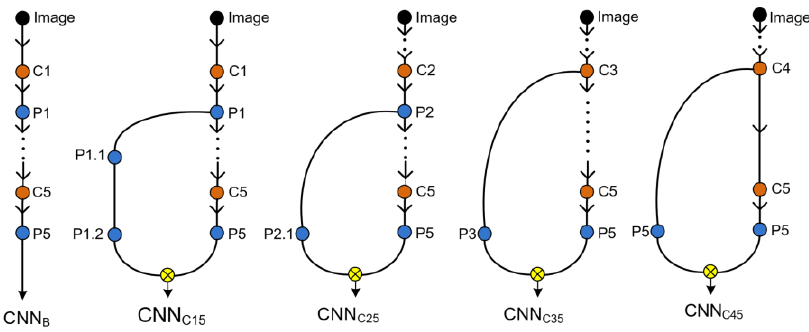
Figure 15. Different layers aggregation structures of proposed CNN model. Figure 15. Di ff erent layers aggregation structures of proposed CNN model. Table 4. Performance comparison of base CNN with modified CNN structures